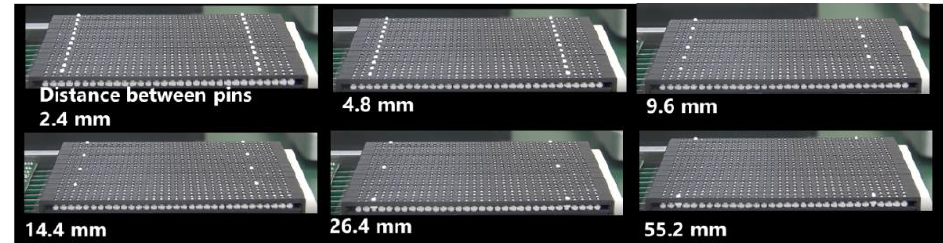
( b ) ( c ) Figure 5. Overview of dot- matrix display (upper left: outward appearance; upper right: subject’s hand posture during experiment; lower: stimulus in which several pins are continuously moved up and down, creating stimulus such as two parallel lines reciprocating). ( a ) Tactile display, ( b ) Method of use, ( c ) Stimulus in which two parallel lines are reciprocated. 4.2. Participants In this case, 11 male Japanese students participated in the psychophysical experi- ments. All the participants were fully informed. Their ages ranged between 22 and 25 yr. All the experiments were approved by the ethics committee of the Nagoya University. 4.3. Experimental Condition The purpose of this experiment was to clarify whether there is an important relation- ship between the VHI and tactile Gestalt. Since the VHI is not induced without movement or when the stimulus condition is a single line, it was assumed that the laws of closure and common fate were the essential factors for VHI induction. Thus, the effects of these factors on the intensity of the VHI were investigated. The basic stimulus conditions were as follows. The line length was 55.2 mm; the distance between the two parallel lines was 60 mm; the stroke was 14.4 mm; and the average speed of the line movement was 80 mm/s. Six types of line conditions were prepared, as shown in Figure 6, in which the interval